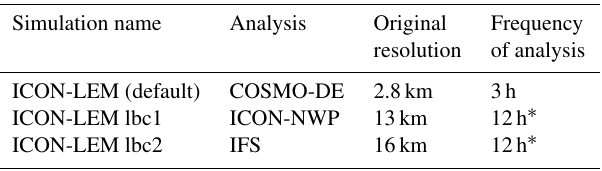
Table 2. Simulations with modified initial and lateral boundary con-